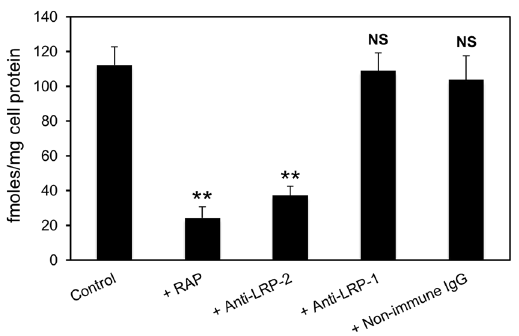
Figure 3. Blocking of megalin/LRP-2 but not LRP-1 inhibits membrane binding of proMMP-2:TIMP-2 complex. BN16 cells were incubated with 10 nM 125 I-proMMP-2:TIMP-2 complex at 4 °C for 2 h to allow surface binding, in the absence or presence of 1 μ M RAP, anti-megalin/LRP-2 IgG (100 μ g/ml), anti-LRP-1 IgG (100 μ g/ ml) or non-immune IgG (100 μ g/ml). After 2 h, surface-bound tracer was measured as in Fig. 2. Values are means ± S.D. of three dishes. ** p < 0.001; NS, not significant, vs control, using Student’s t test.